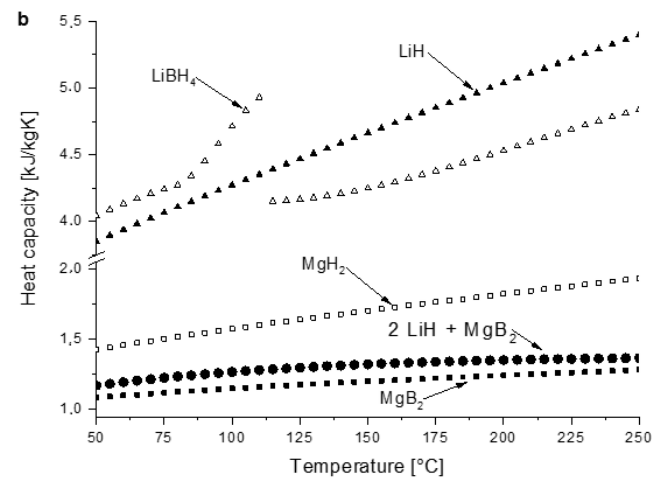
Figure 4. Graphs displaying c p , the specific heat capacity, vs. temperature. Both the data acquired using the “linear temperature ramp” with a rate of 5 °C min − 1 (full circles) and the “enthalpy method” (hollow circles) for 2 LiH + MgB 2 under Ar atmosphere ( a ); the data set plotted with other hydride values, for comparison ( b ).